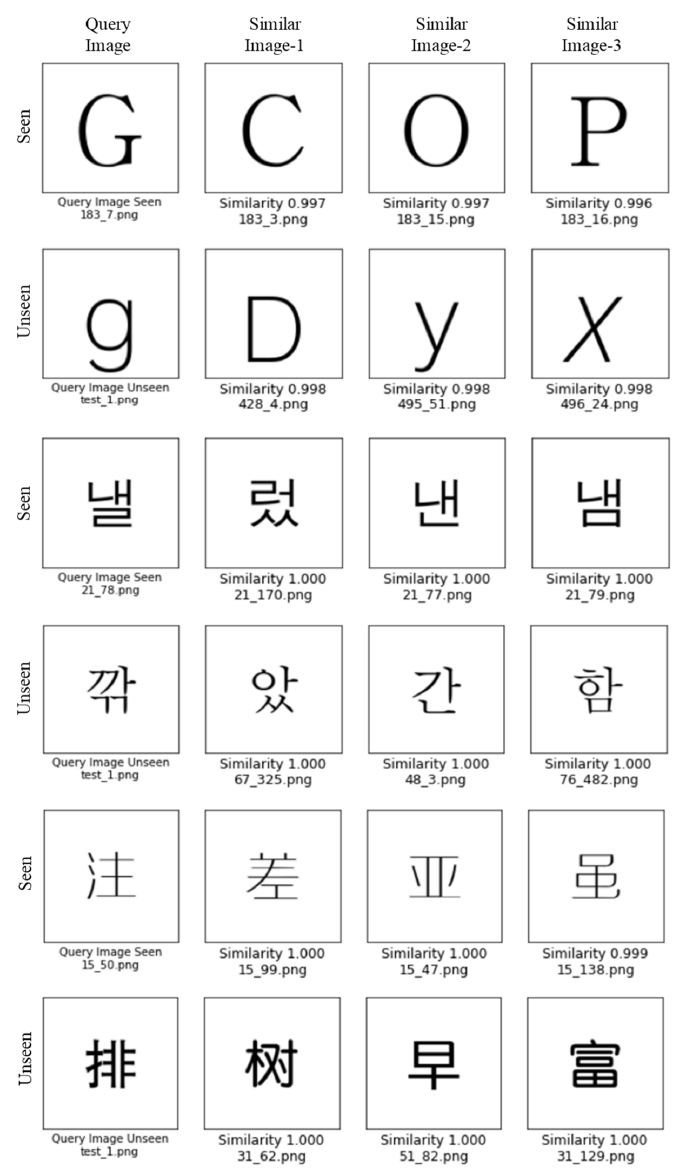
Figure 6. Recommended similar images of query image in Chinese, English, and Korean font styles on seen and unseen images during training based on cosine similarity. Caption of each image shows similarity score to query image, style number, and character number. Table 2. Accuracy comparison of contrastive learning and fully supervised methods for few-shot fine-tuning for new styles.